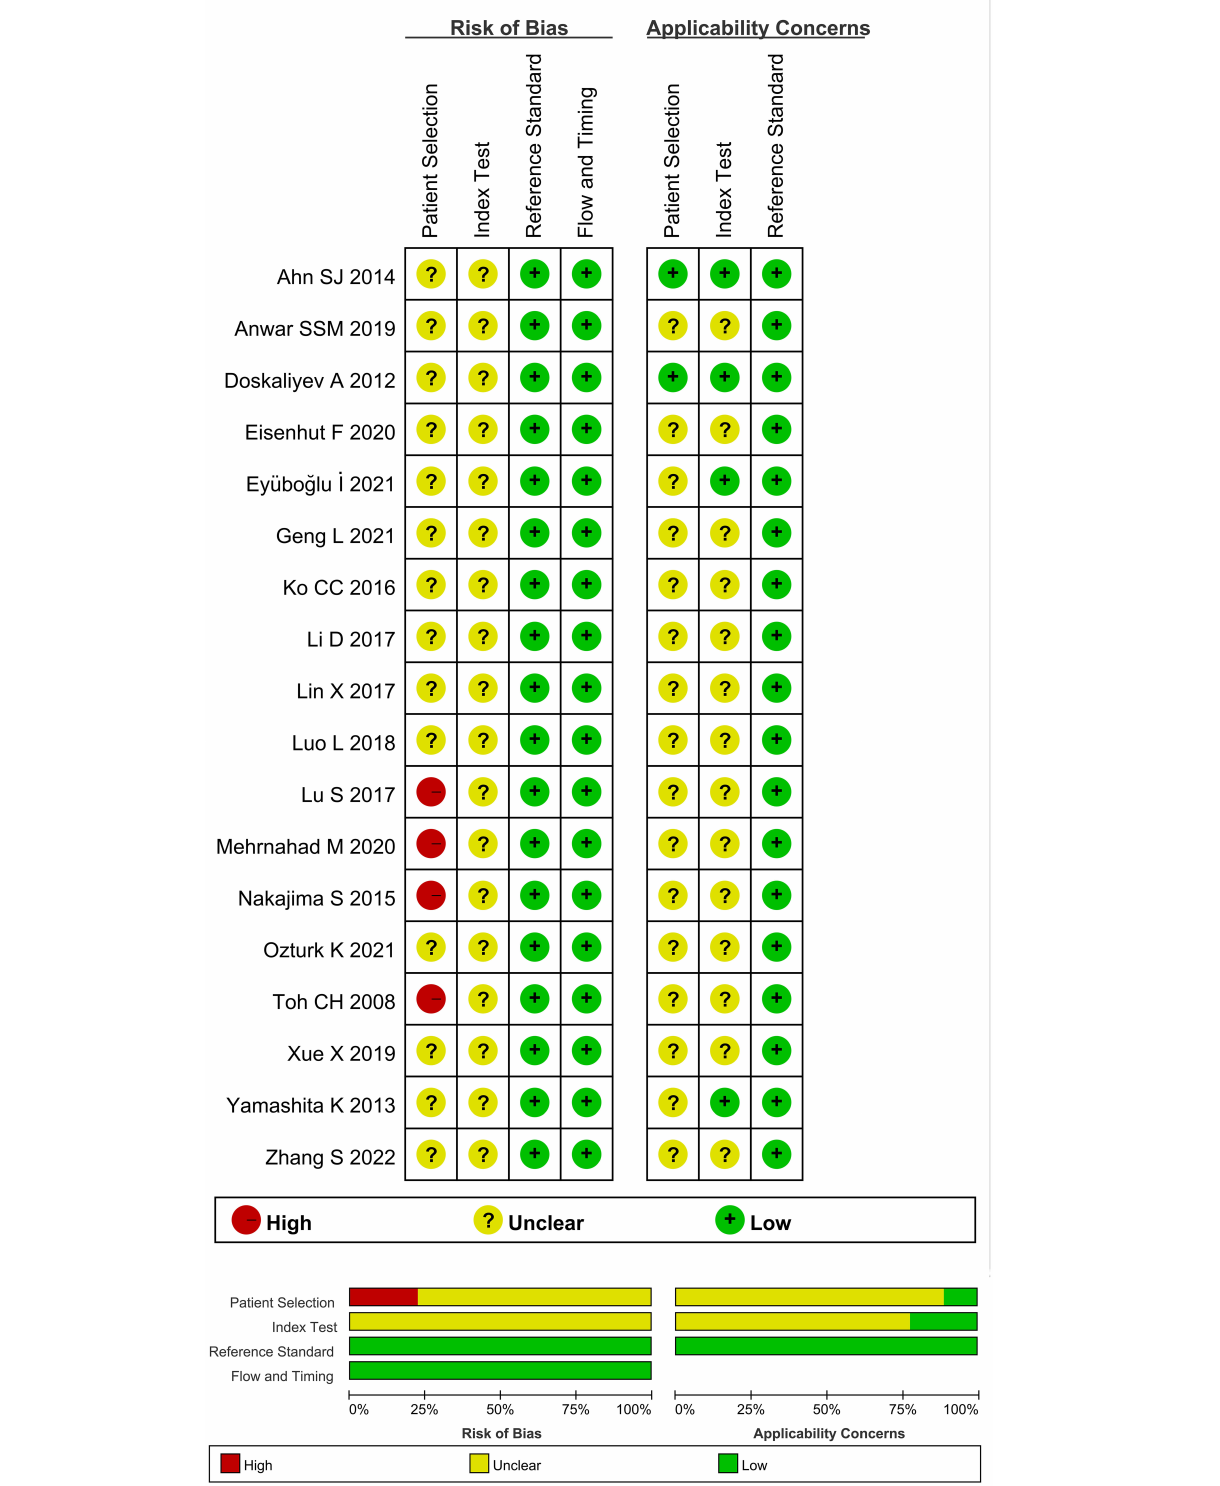
FIGURE 2 | A document quality evaluation chart prepared using the QUADAS-2 tool.